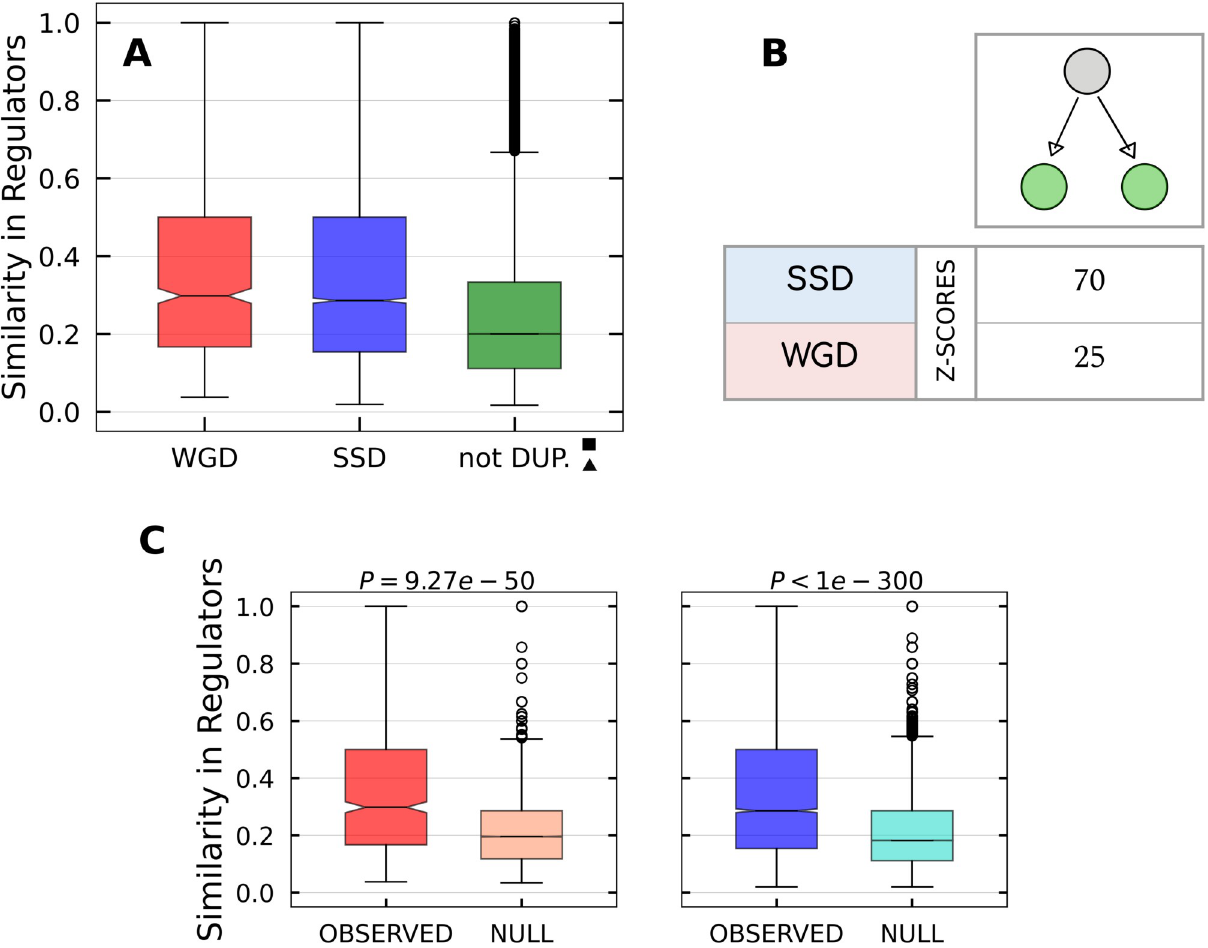
Fig 6. Transcriptional Λ motifs. (A) Similarity distributions for WGD, SSD and not duplicated target genes couples in the ENCODE network. As indicated by the presence of the symbols explained in the Materials and methods section, the difference between SSD and WGD distributions is not statistically significant, while both of them are significantly greater that the similarity distribution of non duplicated genes. (B) Z-scores measuring the enrichment of the Λ motif with respect to the null model. (C) Pairwise comparison between each real similarity distribution and the null distribution for the respective duplication